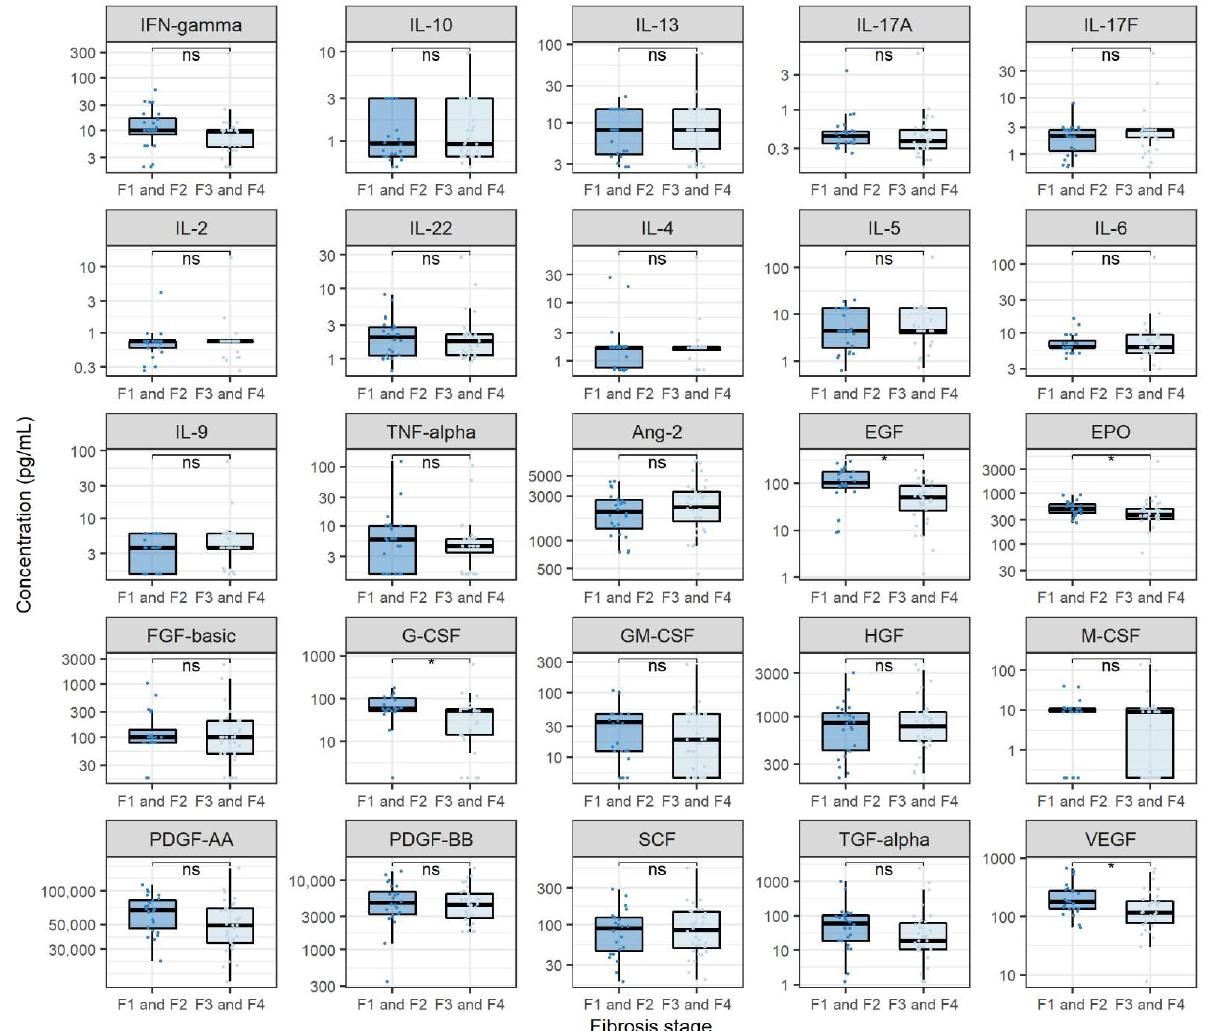
Figure 4. Comparison of cytokine and growth factor levels in chronic hepatitis C patients with different fibrosis stages. The boxes show the median and interquartile range of the distribution, whereas the whiskers extend to the minimum and maximum nonoutlier values of the distribution. Y -axis is logarithmically scaled. F1: mild fibrosis, F2: medium fibrosis, F3: severe fibrosis, F4: liver